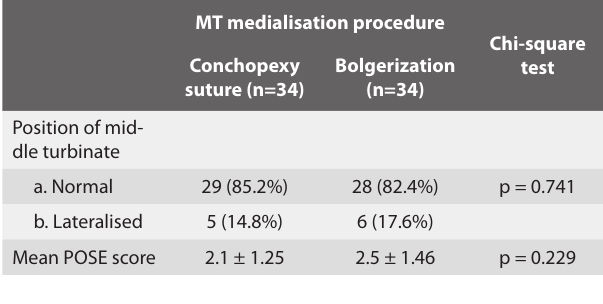
Table 3. Status of maxillary, ethmoid, frontal and sphenoid sinuses at 12th